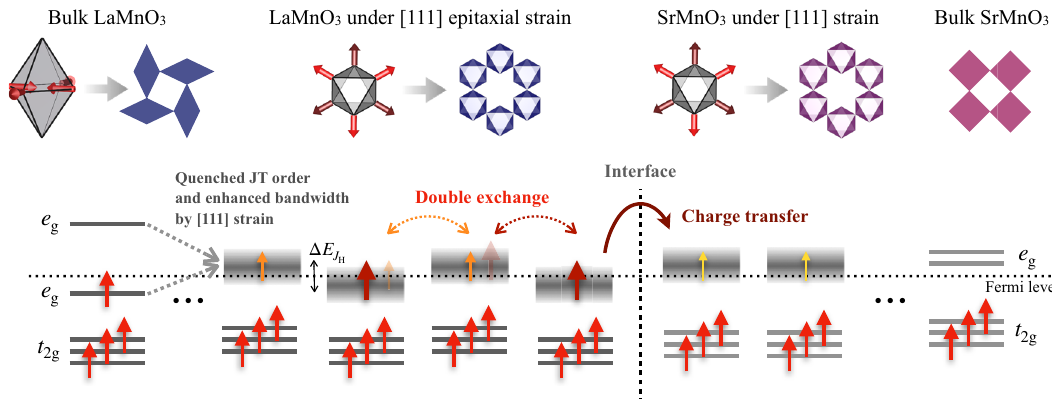
Fig. 5 Sketch of the physical mechanisms driving the interface behaviour in the superlattice. Bulk LaMnO 3 (left side) is an AFM Mott insulator with Jahn-Teller distortion and orbital order, in a d 4 ionic con fi guration. Bulk SrMnO 3 (right side) is an AFM band insulator in a d 3 con fi guration. Across the interface, charge transfer and epitaxial strain lead to partially fi lled bands and breathing distortions, while the Jahn- Teller order is quenched. Metallicity favours the FM order driven by the double-exchange mechanism, and in turn accompanied by spin and charge oscillations.